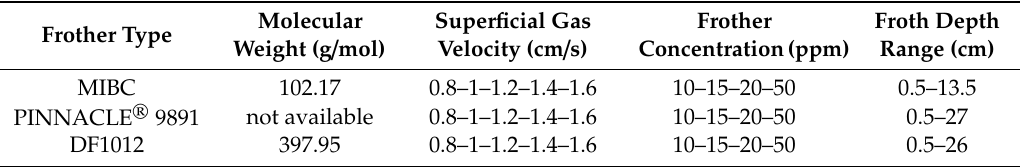
Table 1. Tested conditions in the flotation column.